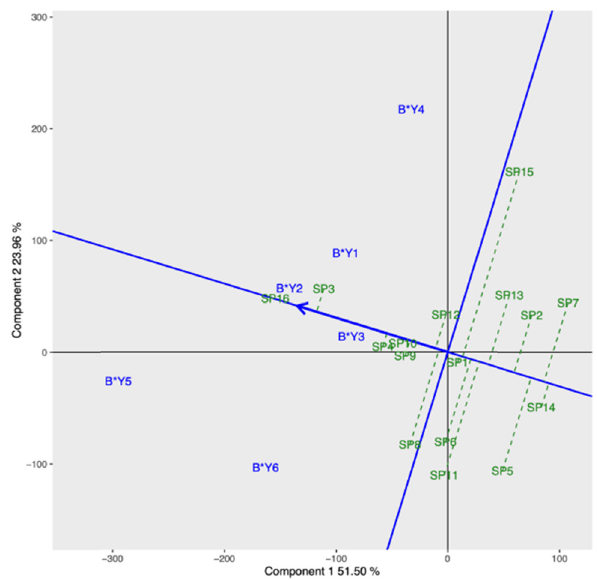
Figure 9: GYT biplot among the yield - trait combination based on multilocation data.